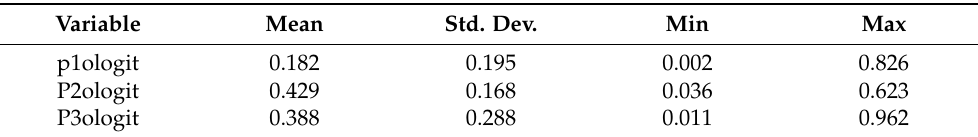
Table A2. Ordered Logit predicted